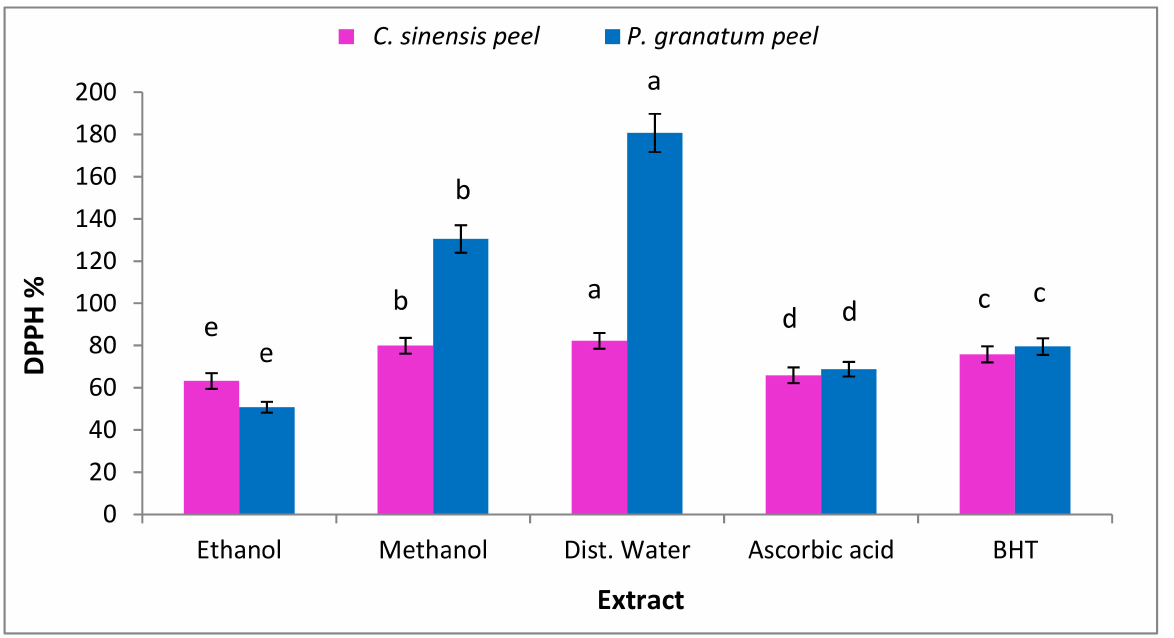
Figure 5. Antioxidant activities of C. sinensis and P. granatum peel extract against DPPH • . Each value is a mean ( ± SD) of three replicates. The different letters on the same bar show a significant difference according to Duncan’s test at p ≤